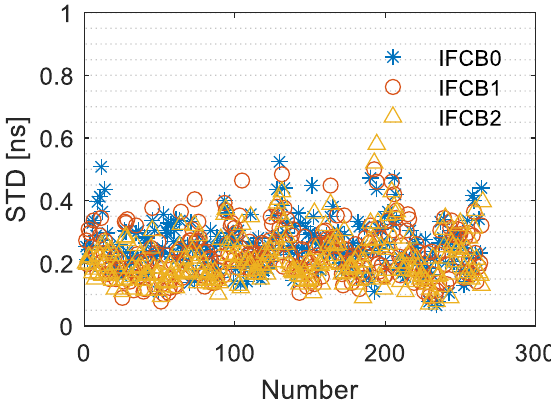
Figure 8. The STD of the ten-day arc solutions with fixed coordinates from three handle schemes. Table 6. The uncertainty (STD) of the GLONASS PPP solutions with fixed coordinates (ns).